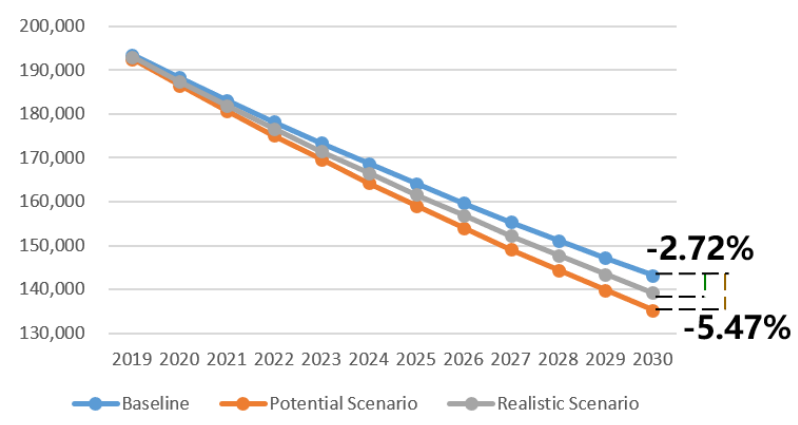
Figure 4. Road tra ffi c injuries for three scenarios through 2030. Figure 4. Road traffic injuries for three scenarios through 2030.